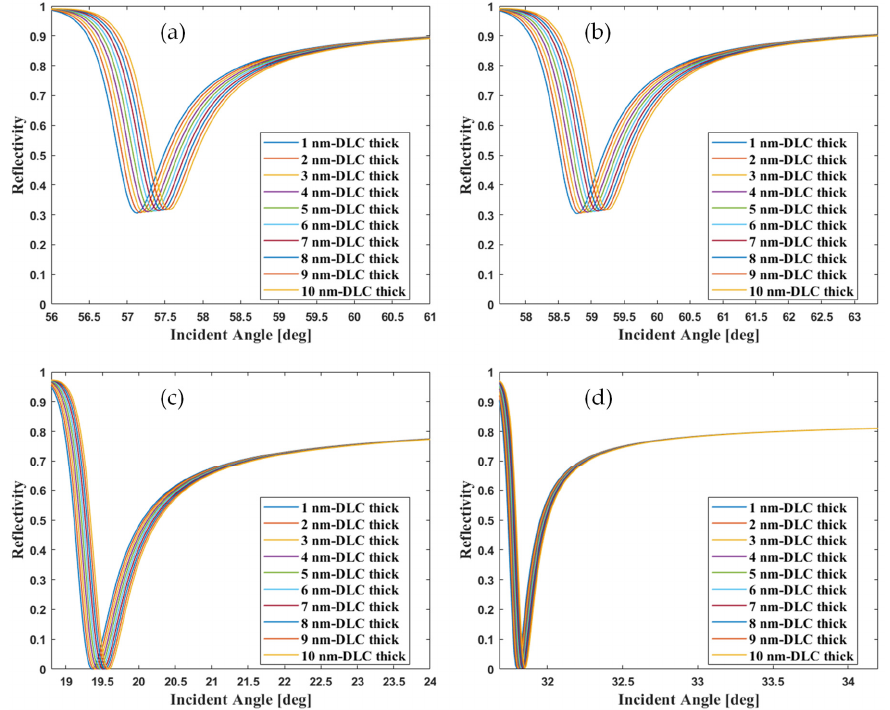
Figure 7. Calculated reflectivity spectra for TE-polarized incident light of the optimized ( a ) sapphire prism/TiN/AlN/air sensor, ( b ) magnesium oxide prism/TiN/AlN/air sensor, and ( c , d ) silicon prism/TiN/AlN/air sensor, showing the shifts in reflectivity minima caused by deposition of DLC films thicknesses of 1–10 nm in steps of 1 nm.